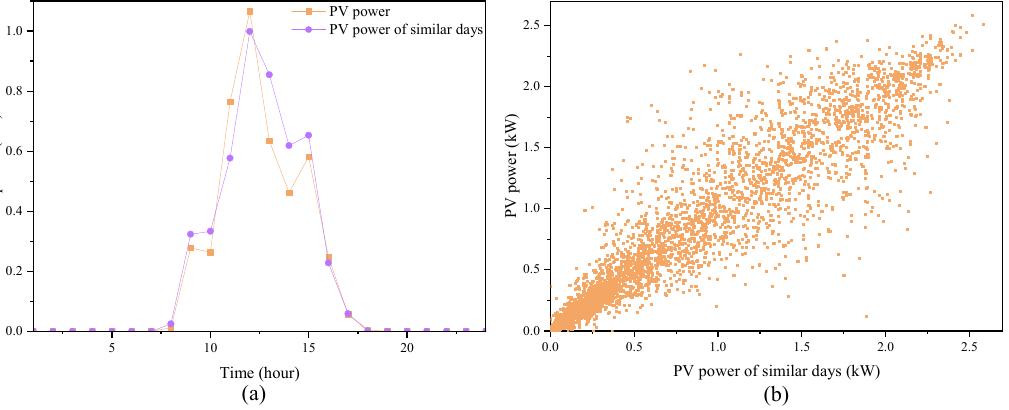
Figure 8. PV power and PV power of similar days curves. ( a ) PV power and PV power of similar days curves of a typical day; ( b ) correlation between PV power of similar days and PV power.